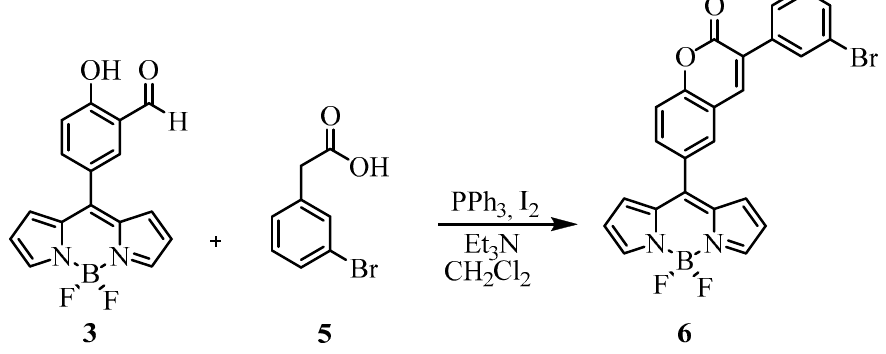
Table 1. Scope and limitations of the Suzuki cross-coupling reaction of BODIPI-coumarin 6 . a.